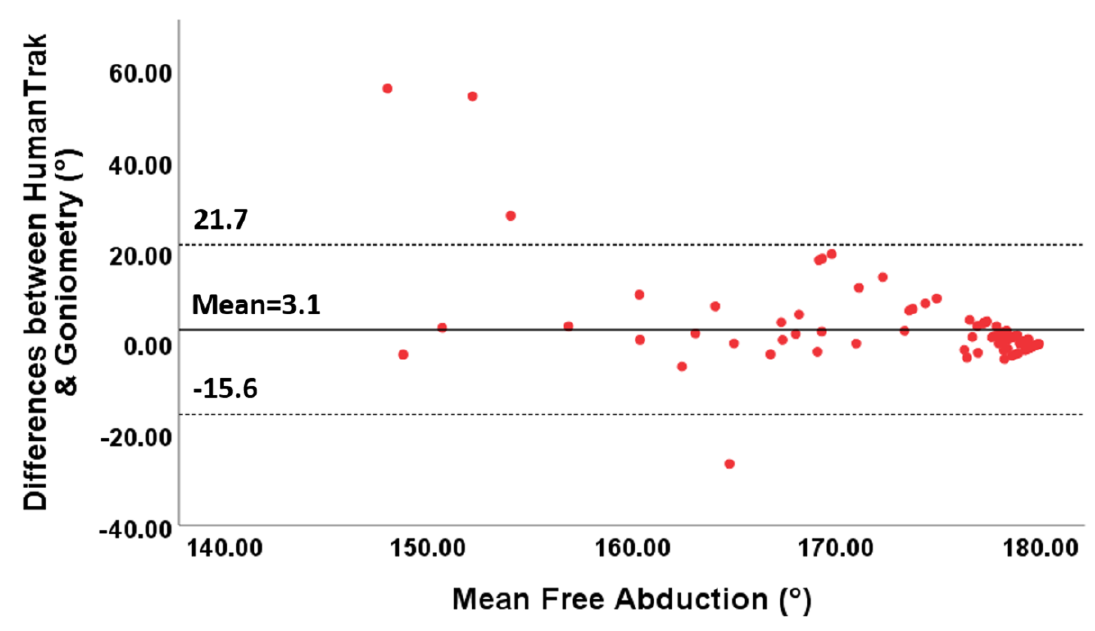
Figure 7. Bland–Altman plots for free abduction with limits of agreement. The differences between the two devices are plotted on the Y-axis, and the mean scores are plotted on the X-axis. For fixed AROM, the points on the Bland–Altman plots demonstrated variability around the mean constant (Figures 8 and 9). Small mean differences between the two methods for forward flexion and abduction were demonstrated (Table 5).